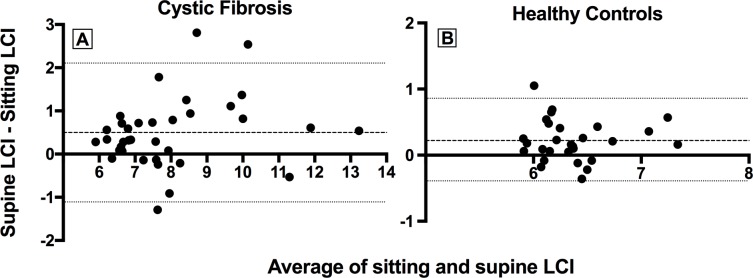
Bland-Altman analysis of sitting and supine LCI in children with CF (A) and healthy controls (B). The dashed line indicates the mean difference and the dotted lines indicate the 95% limits of agreement.